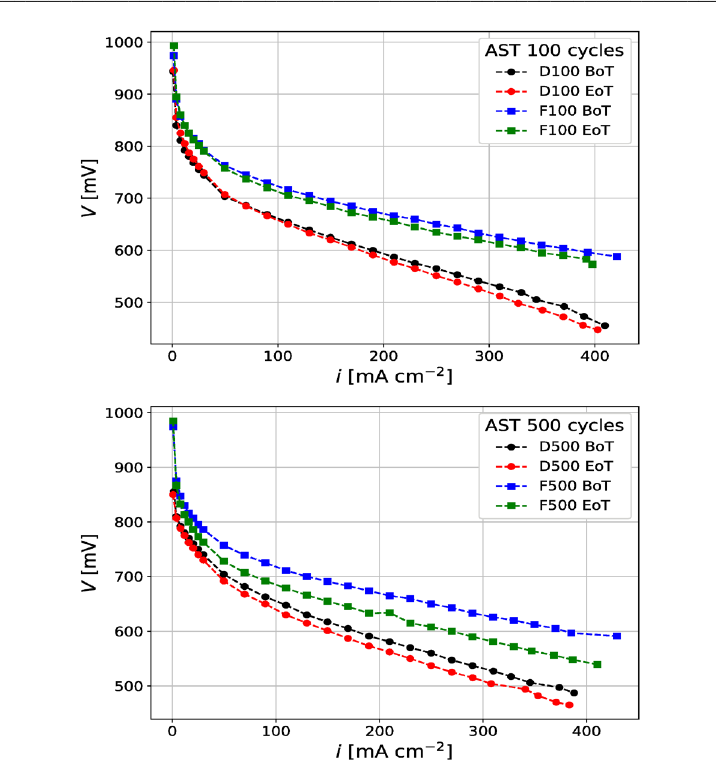
Fig. 2. Plot of the polarization curve ( i-V curve) for Fumea and Dapozol MEA samples – prior to and after the AST